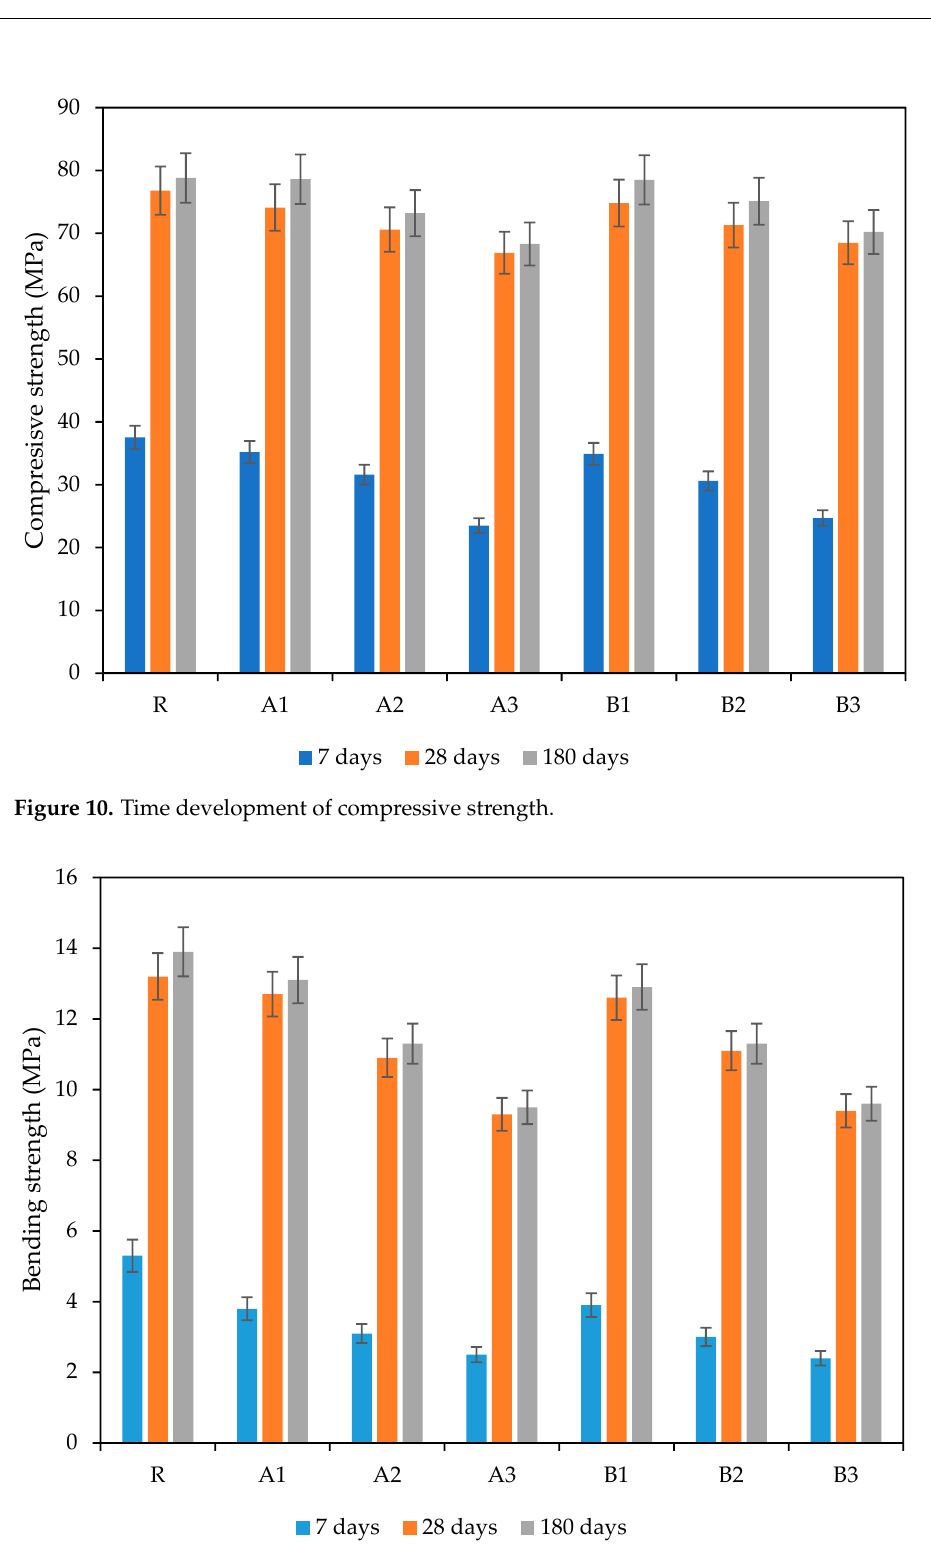
Figure 11. Time development of bending strength.